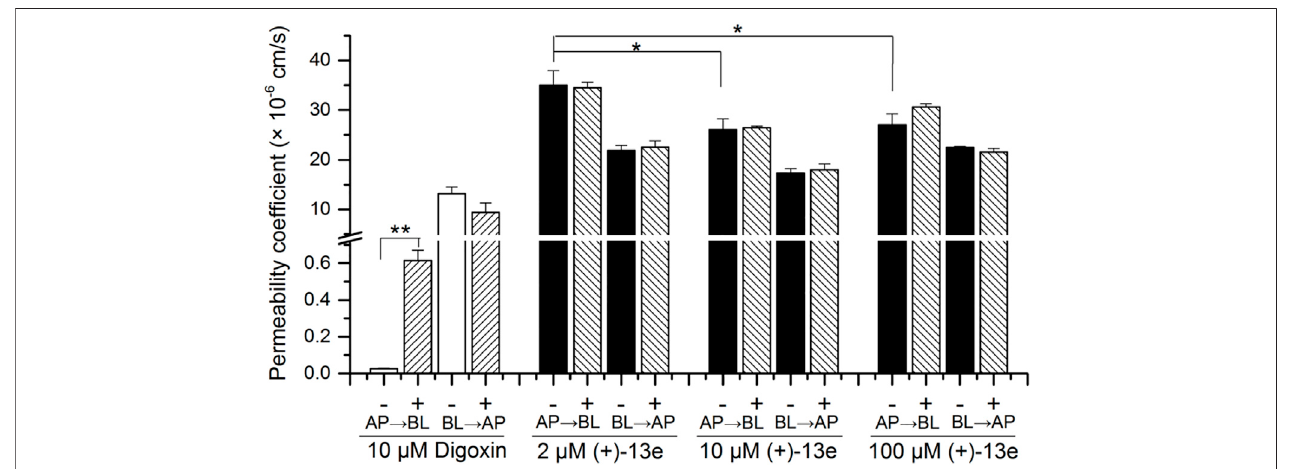
FIGURE 4 | Bidirectional permeability of (+)-13e in Caco-2 cell monolayers. HBSS containing (+)-13e (2, 10 and 100 μ M) or digoxin (10 μ M) was loaded into either the apical (AP) or basolateral (BL) chambers with (+) or without (-) verapamil (30 μ M, P-gp inhibitor) for 2 h incubation at 37 ° C. Data are presented as the mean ± SD of